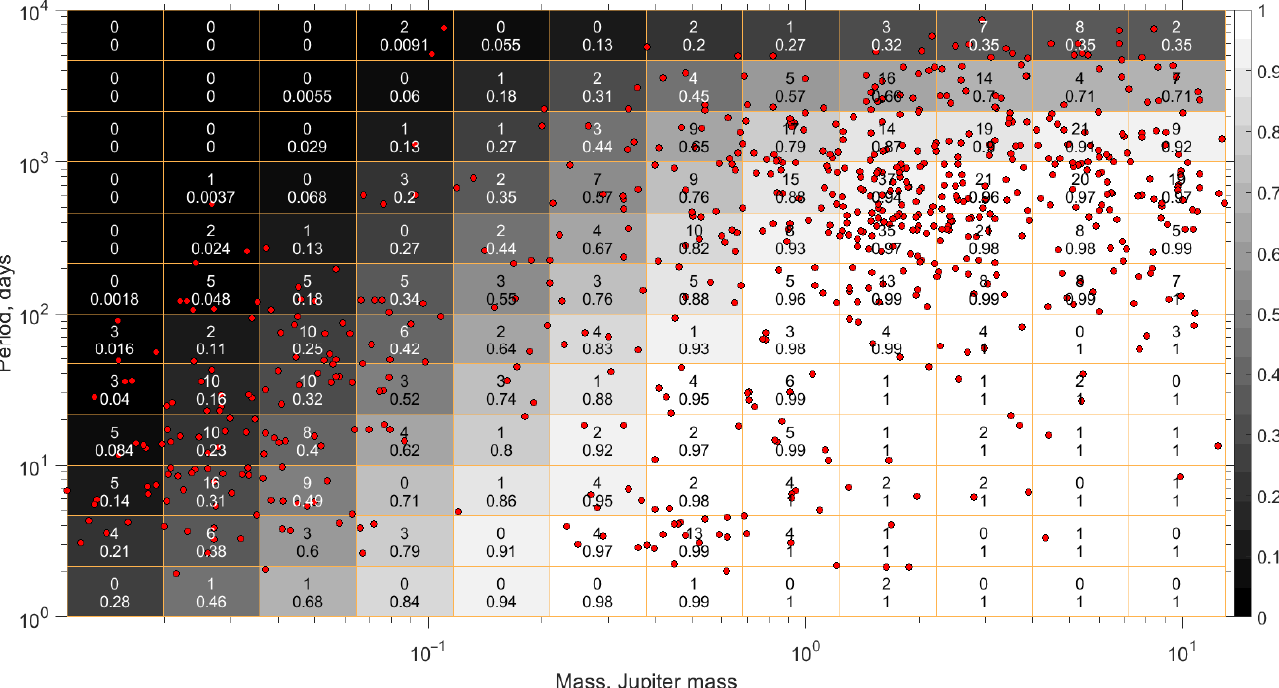
Figure 1. The detectability window W in the form of a map in the m – P plane obtained with the coefficients γ = 0.8 and δ = 2.0 in (5a) and (5b). The upper and lower numbers in each of the cells (Δ m , Δ P ) present the number of known planets with the minimum mass and the orbital period in the corresponding interval and the probability of detecting planets with these parameters, respectively. The degree of shading a cell corresponds to the detection probability for this cell according to the scale on the right. The red dots show the positions of actually detected RV planets in the m – P plane.